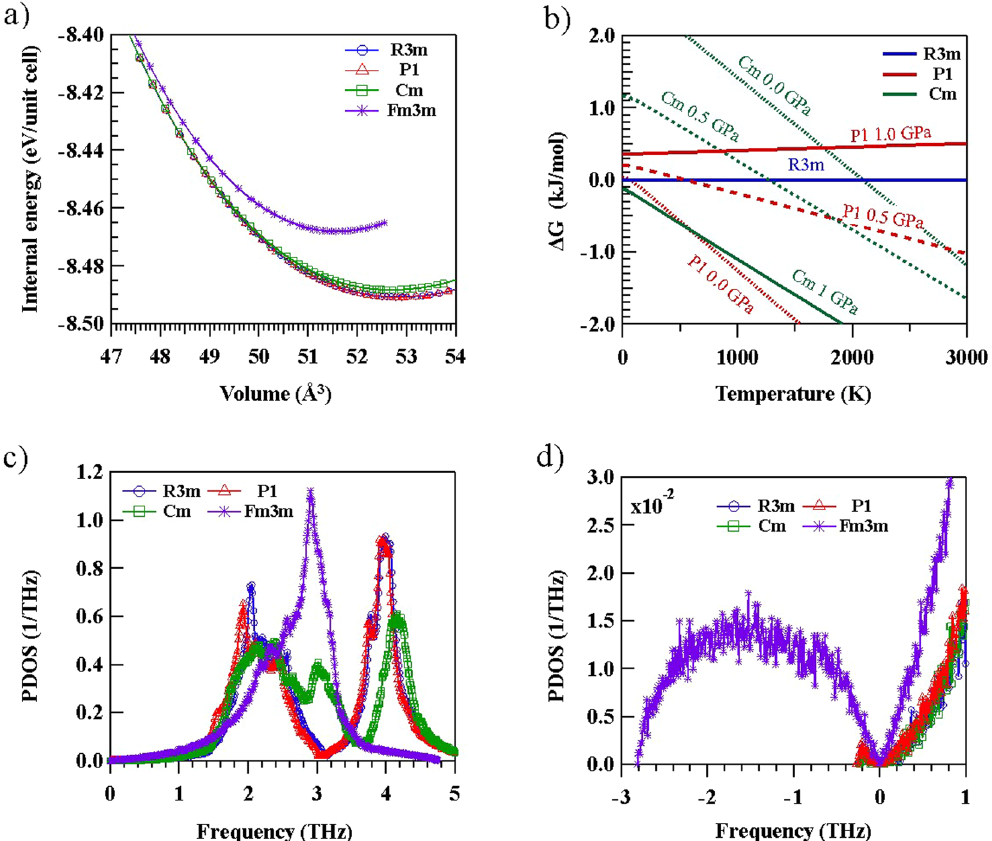
Figure 2. ( a ) Calculated volume versus internal energy for the various studied crystal structures. P1 and R3m exhibit stable characteristics under ambient pressure, whereas Cm becomes stable under compression. ( b ) Calculated difference between the Gibbs free energies of different structures. The Gibbs free energy of R3m serves as a reference. ( c ) Calculated phonon density of states (PDOS) for P1, R3m, and Cm. ( d ) Amplified view of the of negative frequency region. Only Fm3m exhibits PDOS at negative frequencies, implying structural